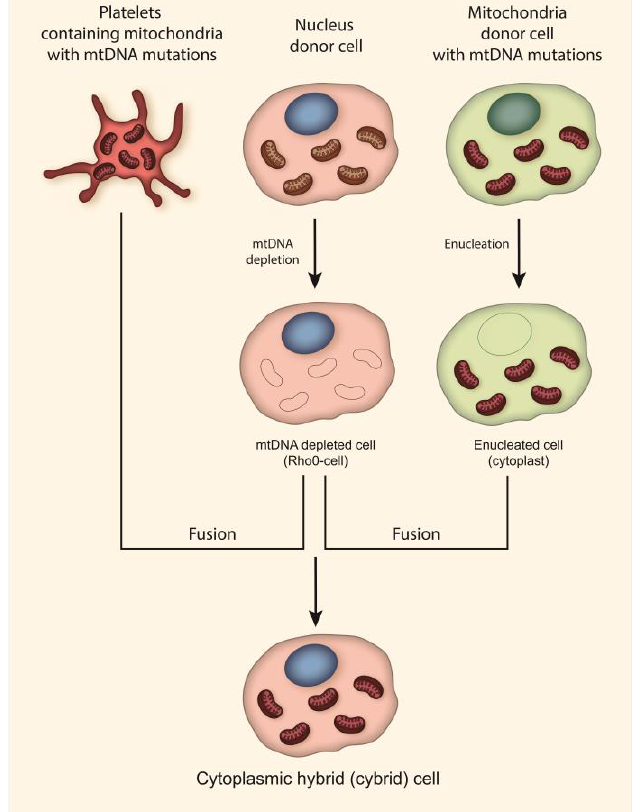
Figure 2. Cybrid cell creation techniques. Cybrids are produced through the fusion of cytoplasm from nucleated cells (Rho0) with enucleated cells (cytoplast) or platelets from patients with mitochondrial diseases. Nucleus donor cells undergo depletion of mtDNA prior to fusion. Thus, cybrids contain mitochondria with mtDNA mutations and a nuclear genome of healthy donors or common cell lines. Other models for studying the mitochondrial diseases mentioned above are iPS